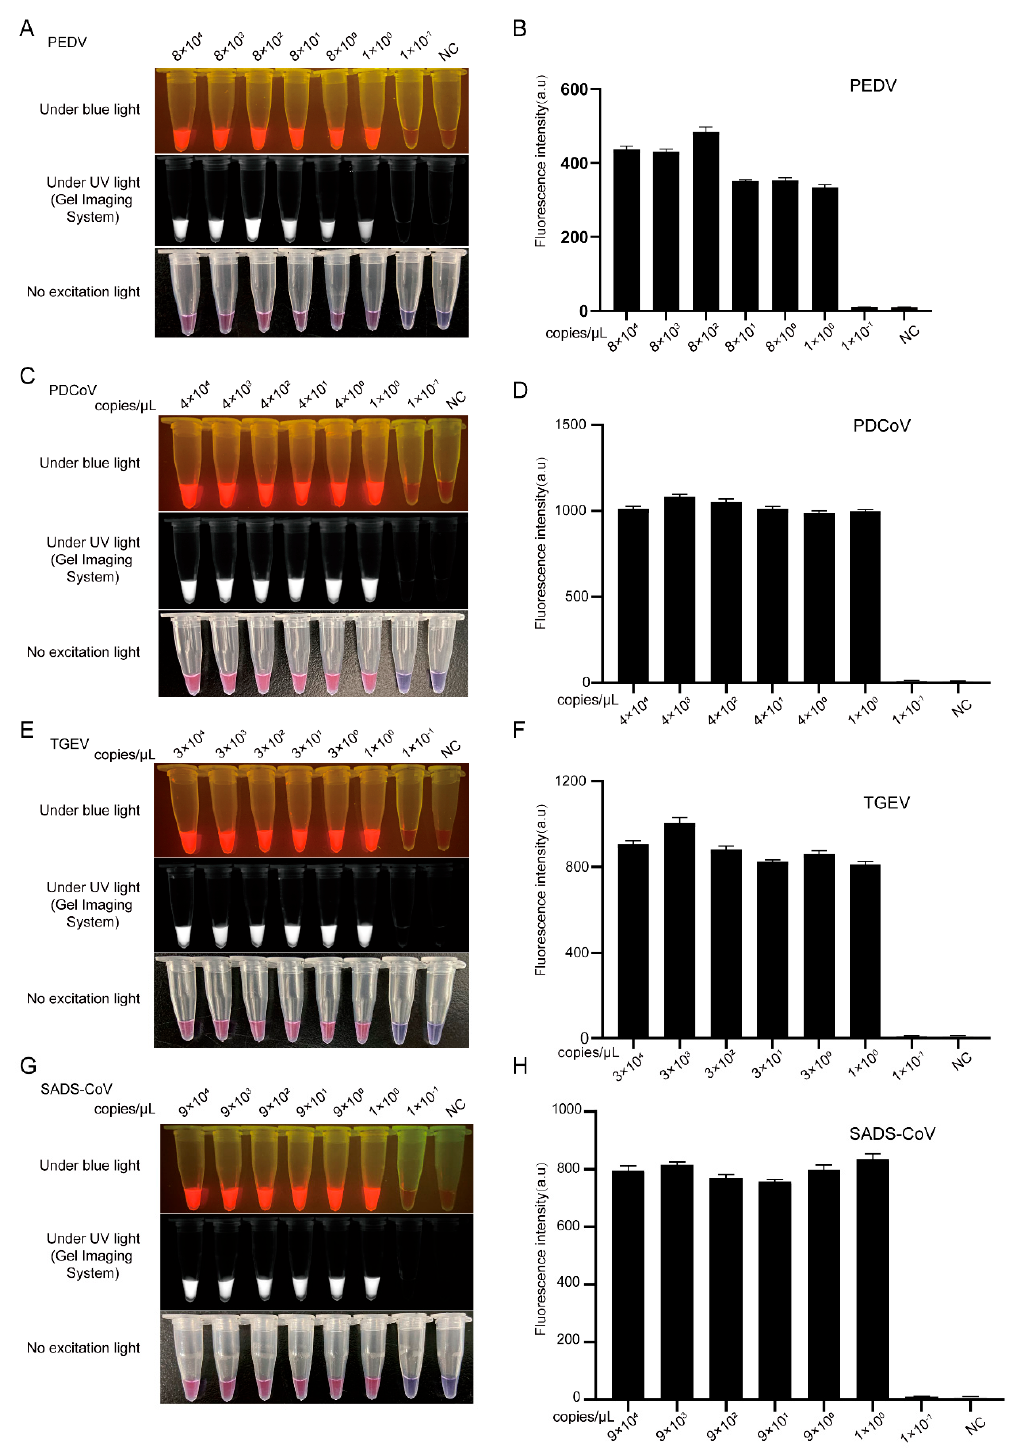
Figure 2. Sensitivity of CRISPR/Cas12a combined with LAMP assay for portable detection of PEDV, PDCoV, TGEV, and SADS-CoV. ( A , C , E , G ) Colorimetric/fluorescence signals from a series of 10-fold dilutions of plasmid DNA by CRISPR/Cas12a coupled with LAMP assay. ( B , D , F , H ) Sensitivity of the CRISPR/Cas12a coupled with LAMP assay quantified by a multi-functional microplate reader ( n = 3). No excitation light stands for white light; PEDV, porcine epidemic diarrhea virus; TGEV, transmissible gastroenteritis virus; PDCoV, porcine deltacoronavirus; SADS-CoV, swine acute diar- rhea syndrome coronavirus; NC, negative control. Data are represented as mean ± SEM.